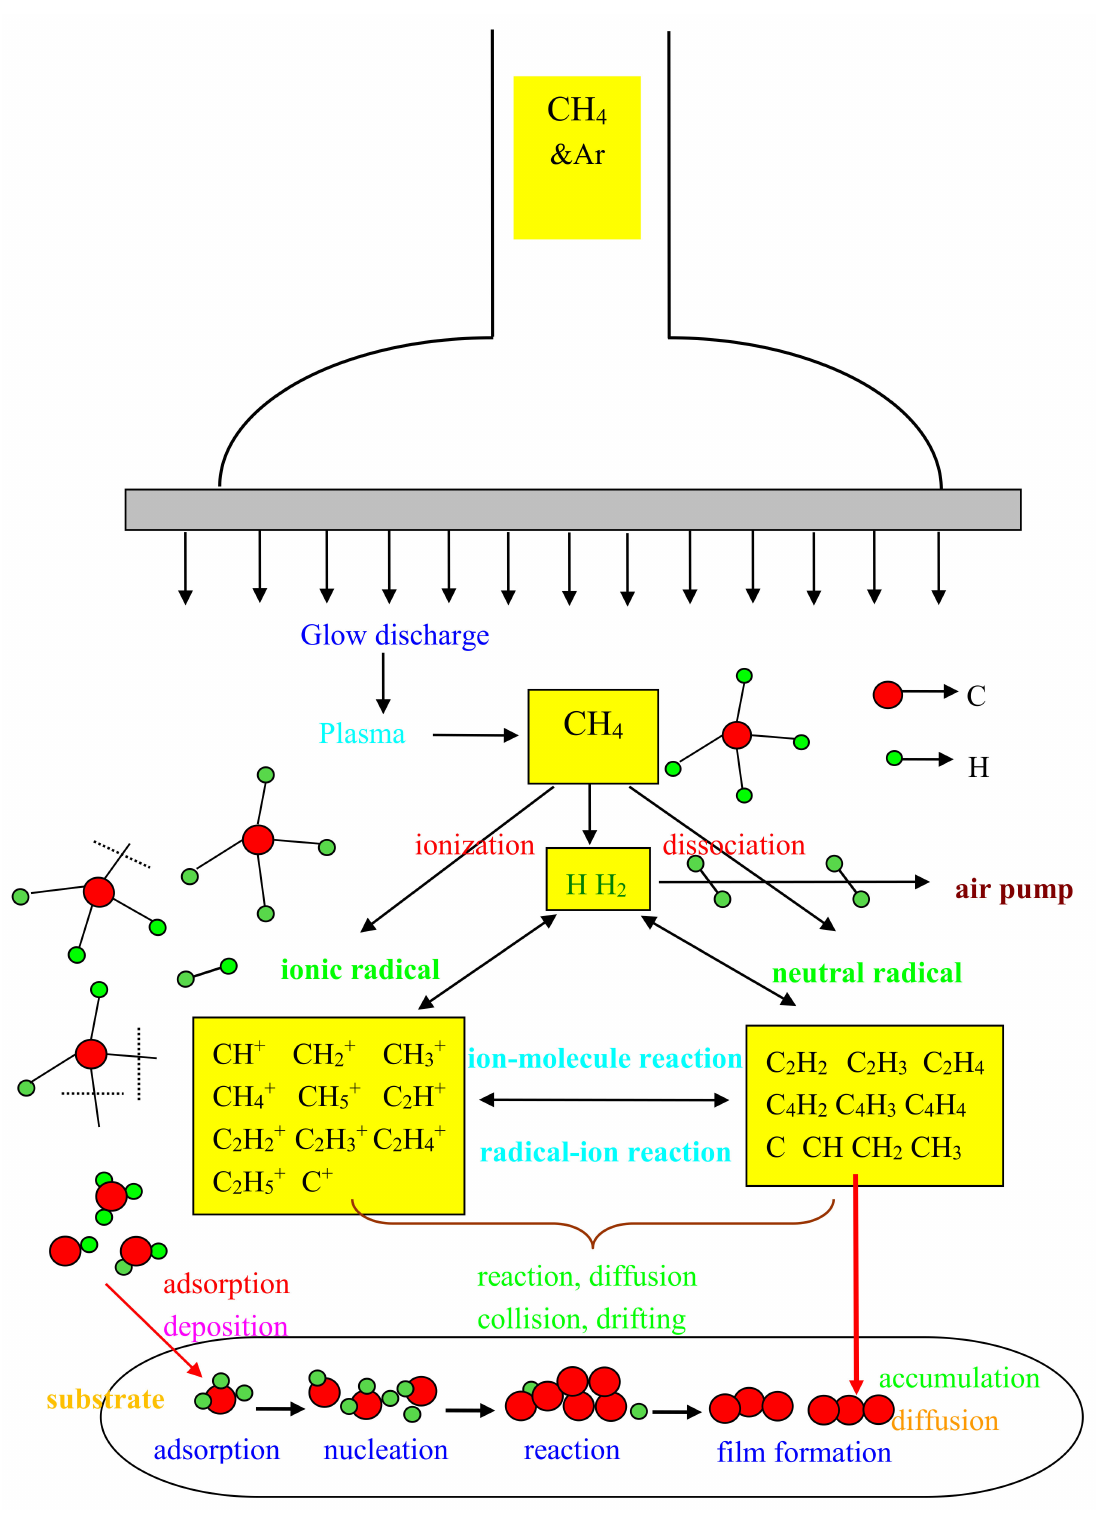
Figure 4. Detailed process of growing NGFs by RF-plasma-enhanced chemical vapor deposition